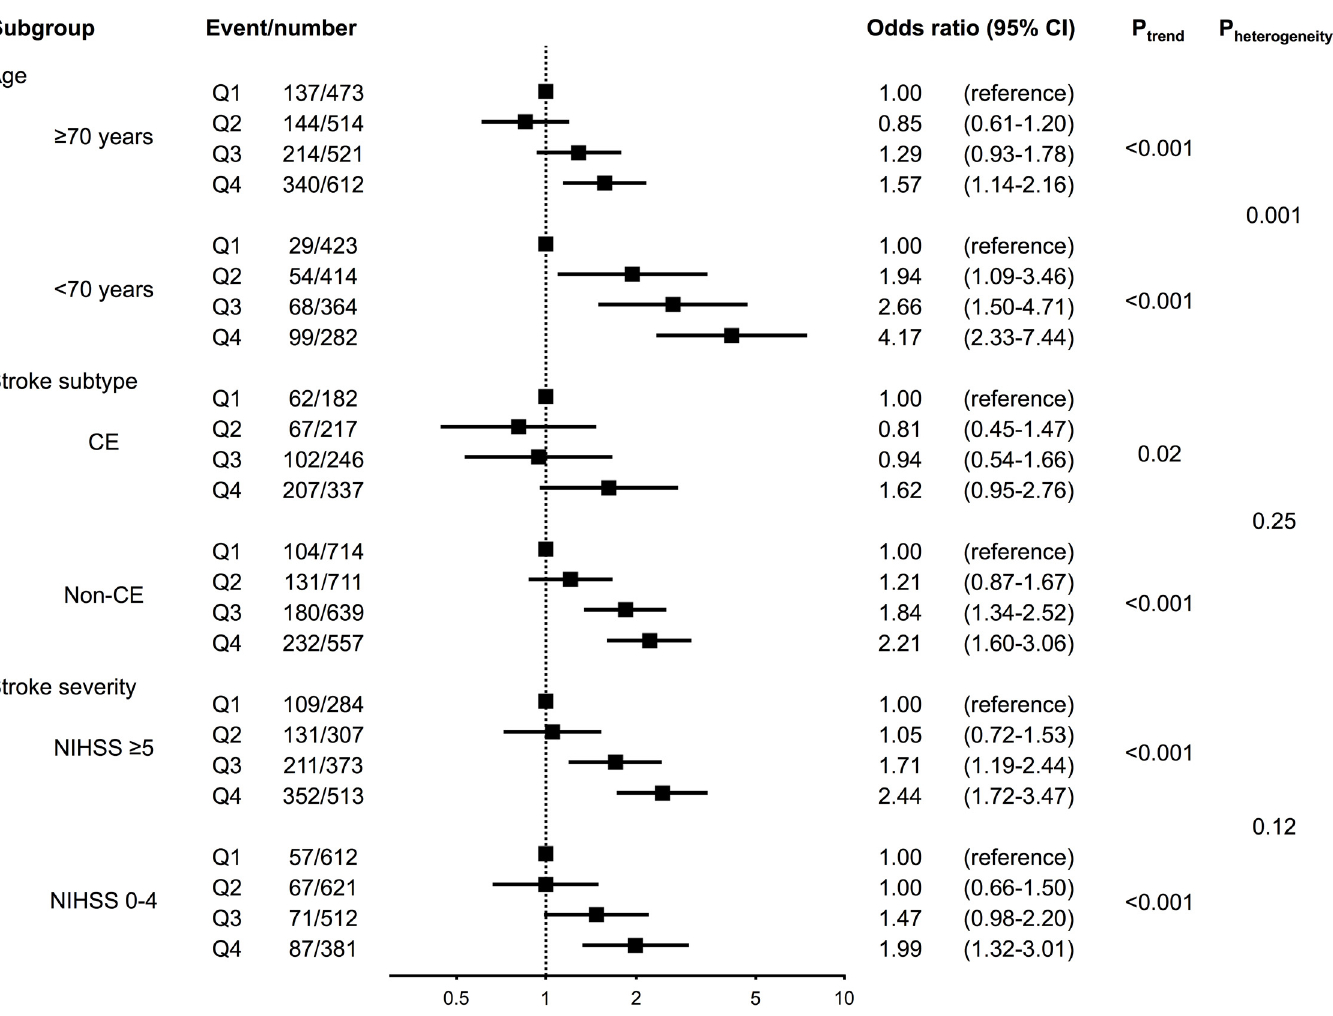
Fig 1. Subgroup analysis. Multivariable-adjusted odds ratio and 95% confidence interval of each hsCRP quartile for poor functional outcome at 3 months are shown according to subgroups. Q1 – Q4 indicate the four groups according to the quartile of hsCRP (mg/L). The multivariable model included age,